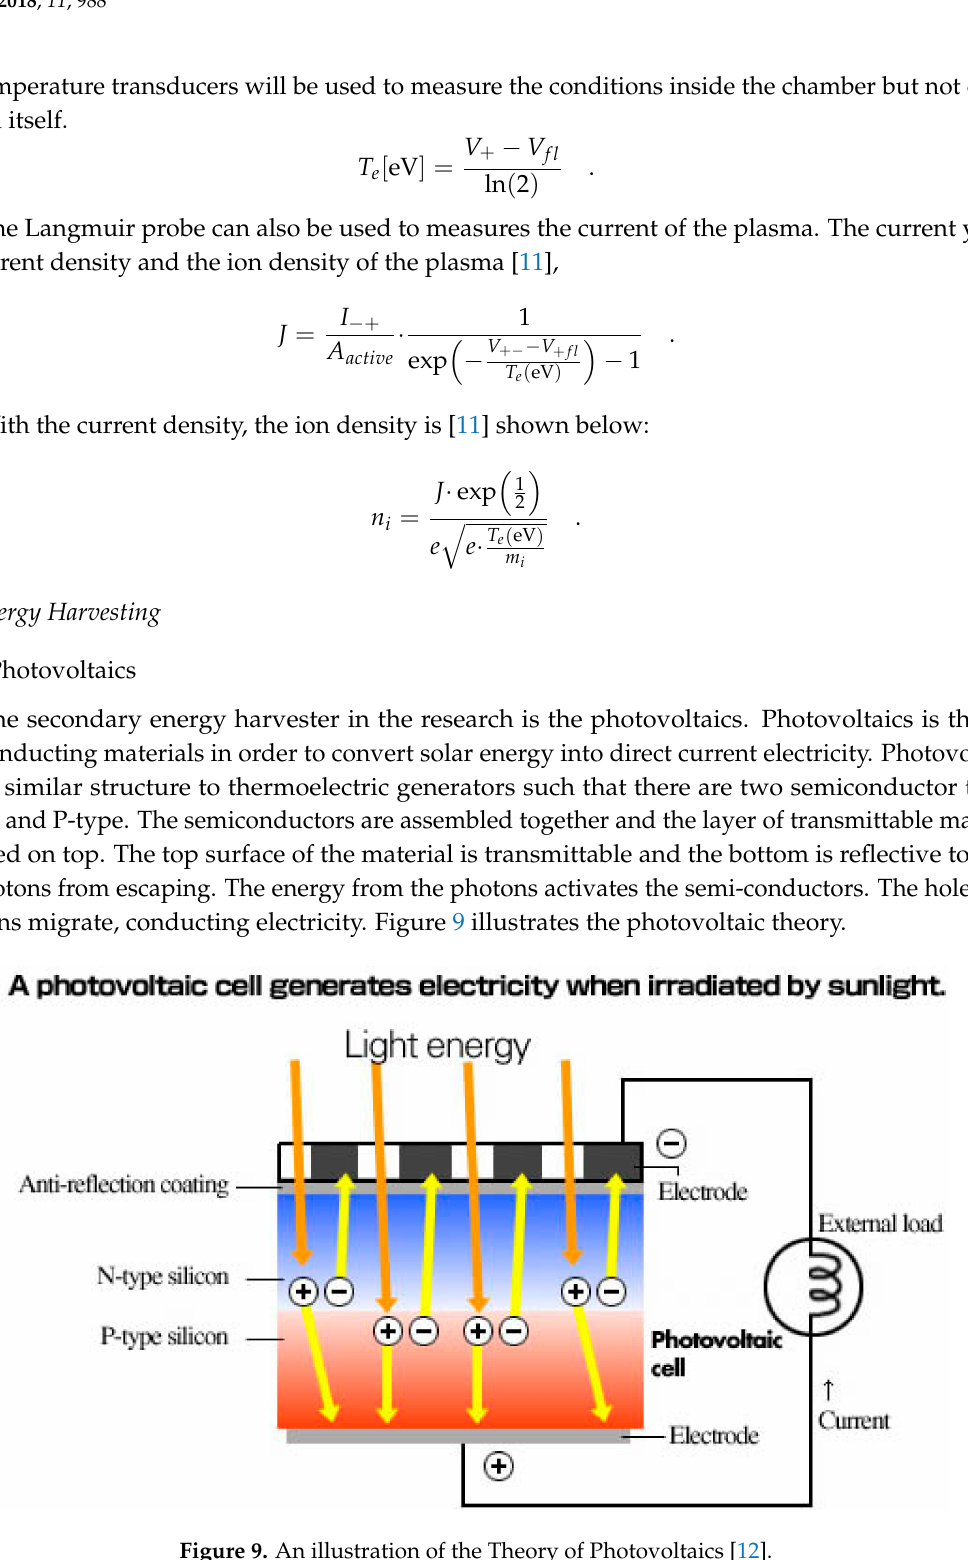
Figure 9. An illustration of the Theory of Photovoltaics